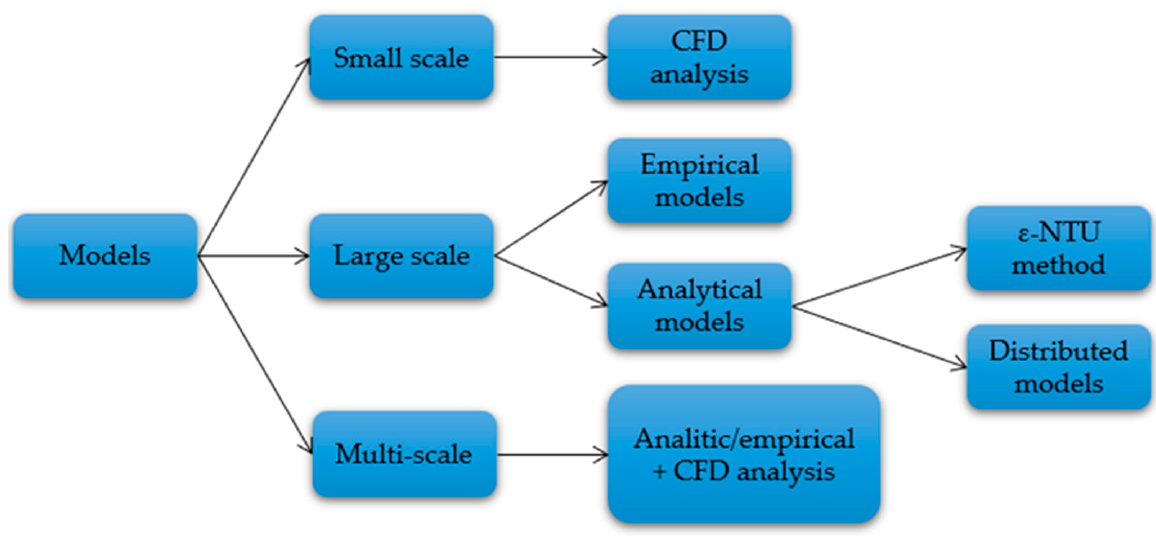
Figure 4. Classification for HX modelling.